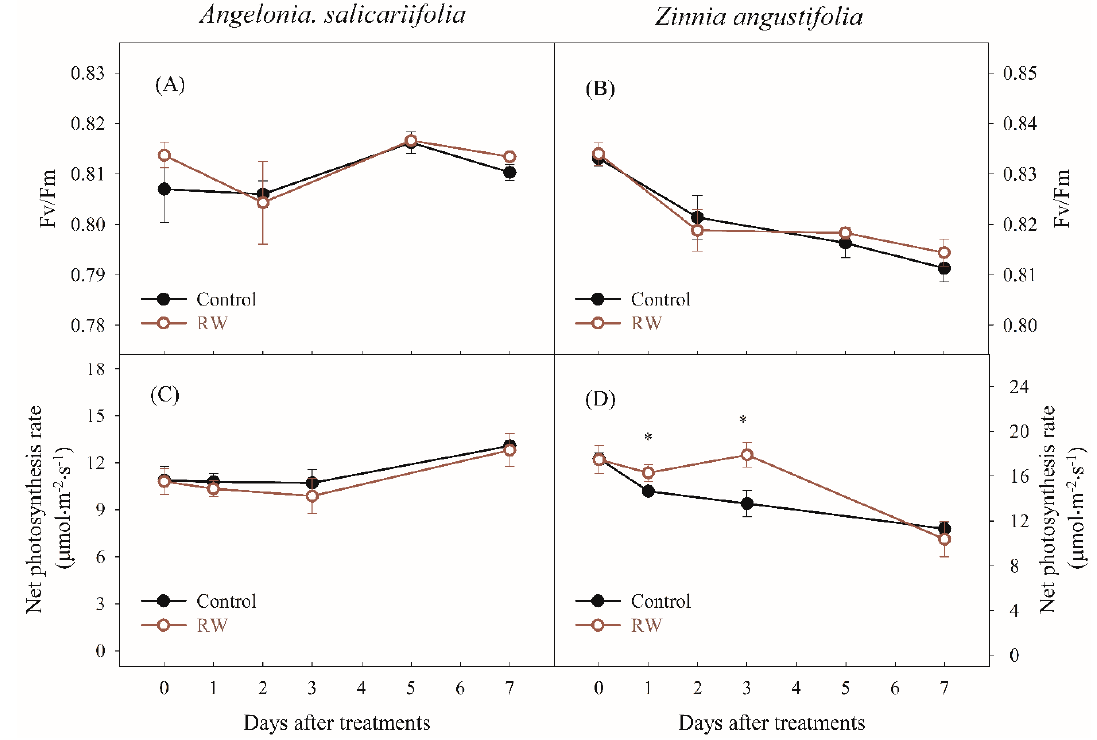
Figure 6. Effects of seven days of waterlogging with tap water (control) and simulated reclaimed water (RW) on maximal quantum yield of photosystem II (Fv/Fm) values ( A and B ) and the net photosynthesis rate ( C and D ) of Angelonia salicariifolia (A and C) and Zinnia angustifolia (B and D). * p < 0.05 between the control and RW plants by a t -test. ( n =5).